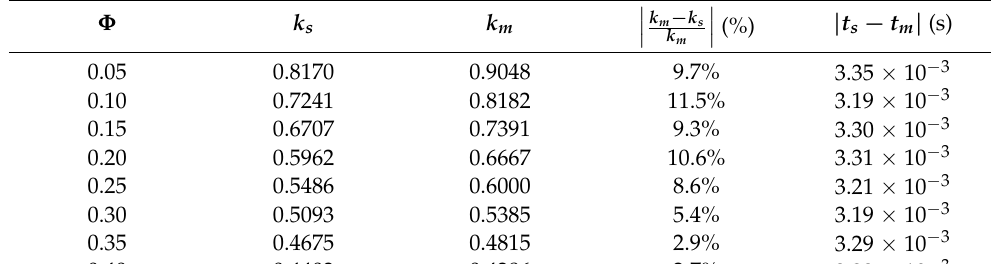
Table 1. The effective thermal conductivity in material made of AlN, at 300 k, with the comparison of the EMT method and the MCBU method.